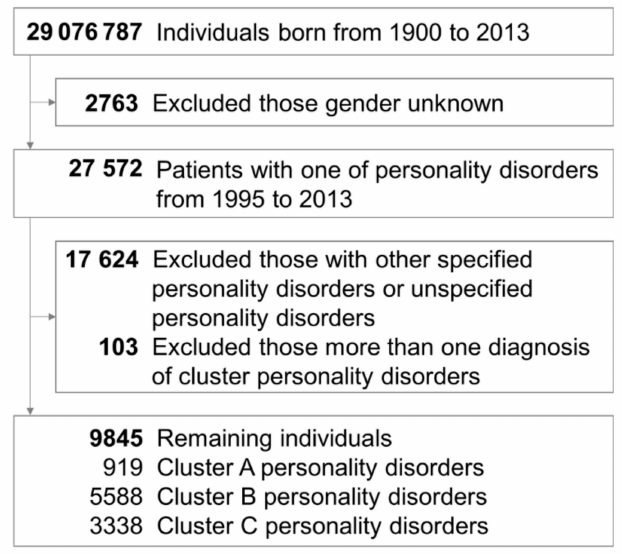
Figure 1. Flowchart showing the selection procedure of study